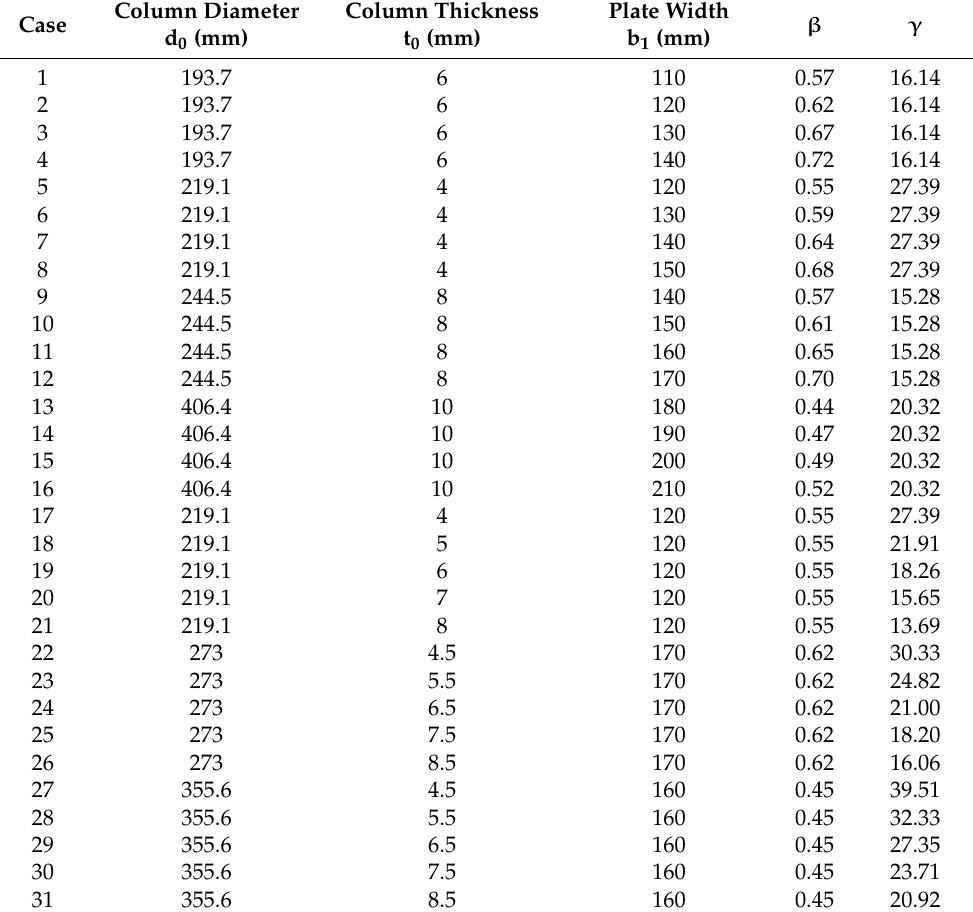
Table 1. Selected geometrical configurations for the parametric analysis.